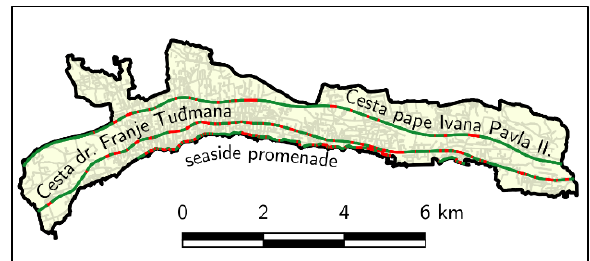
Figure 8. Three main corridors in the City of Kaštela